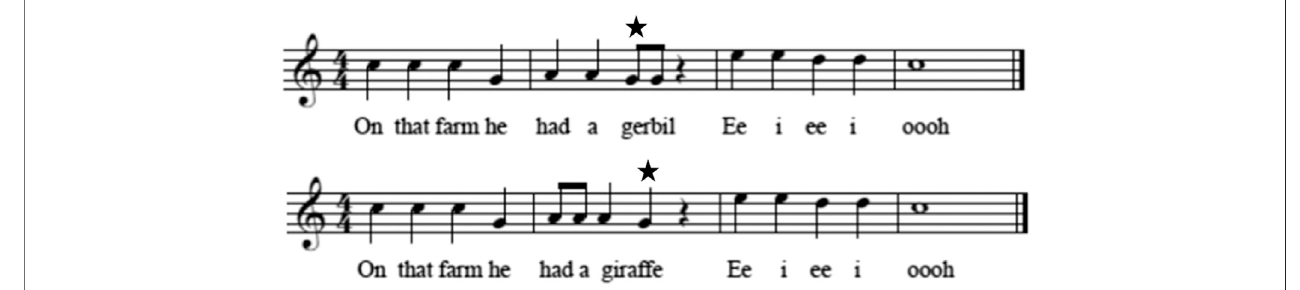
FIGURE 1 | Rhythmic strategies corresponding to gerbil and giraffe for the song Old